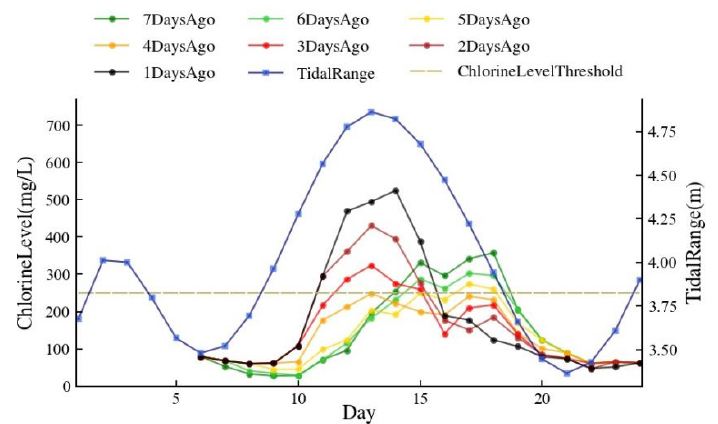
Figure 11. The variation of chlorine level when the river discharge is increased in advance of N days before the arrival of the high tide.